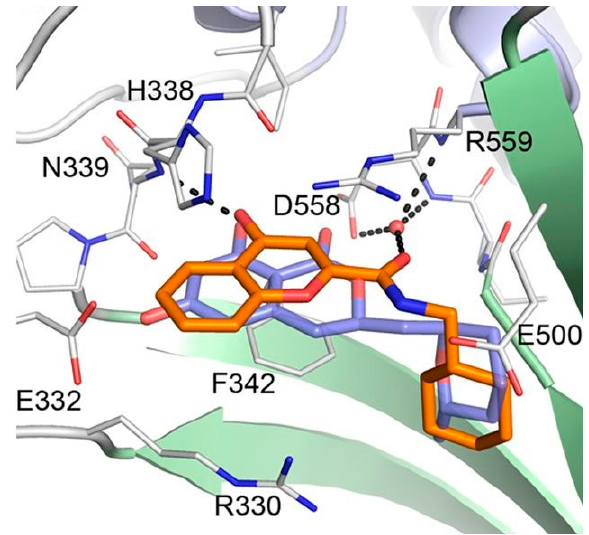
Figure 7. Binding modes of cladosporin and 20 to Pf LysRS1. Pf LysRS1:Lys: 20 showing the binding mode of 20 (C atoms, gold) bound to the ATP site of Pf LysRS1 (PDB ID code 6AGT) superimposed upon Pf LysRS1:Lys:cladosporin (cladosporin C atoms, slate; PDB ID code 4PG3). The image was reproduced from reference 29 by Baragaña et al. and adapted for repurposing.